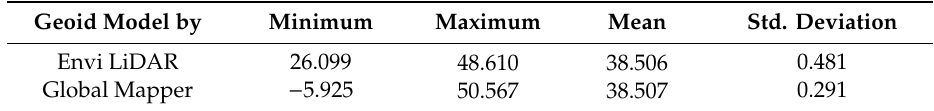
Figure 11. Before removing blunders with 1- 𝜎 test: Local geoid surfaces using DTMs generated by ( a ) Envi LiDAR and ( b ) Global Mapper. Table 2. Statistics of calculated geoid heights from models using Envi LiDAR and Global Mapper software over the whole test site (m).